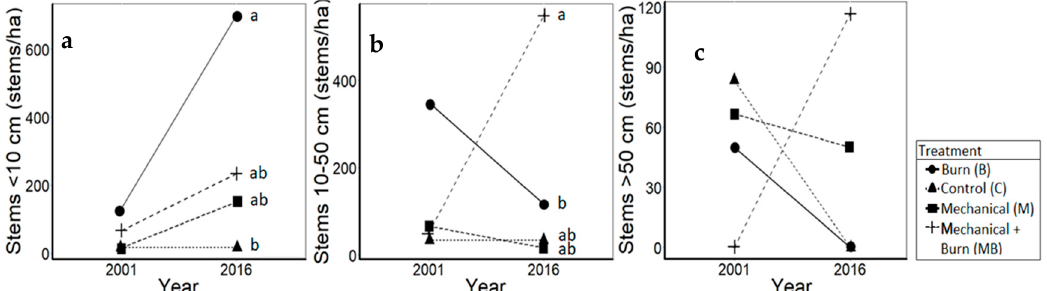
Figure 5. Pine primary guild stem density results for stems ( a ) < 10 cm, ( b ) 10–50 cm, and ( c ) > 50 cm in height showing the 4 treatment e ff ects (control = C, burned = B, mechanical removal of stems < 10 cm in diameter at breast height (DBH) = M, and mechanical removal of stems < 10 cm DBH + burned = MB) from 3 analysis of variance (ANOVA). Post-hoc comparison (Tukey’s Honest Significant Di ff erence Test; THSD) letters show di ff erences between treatment e ff ects from 2001 to 2016.